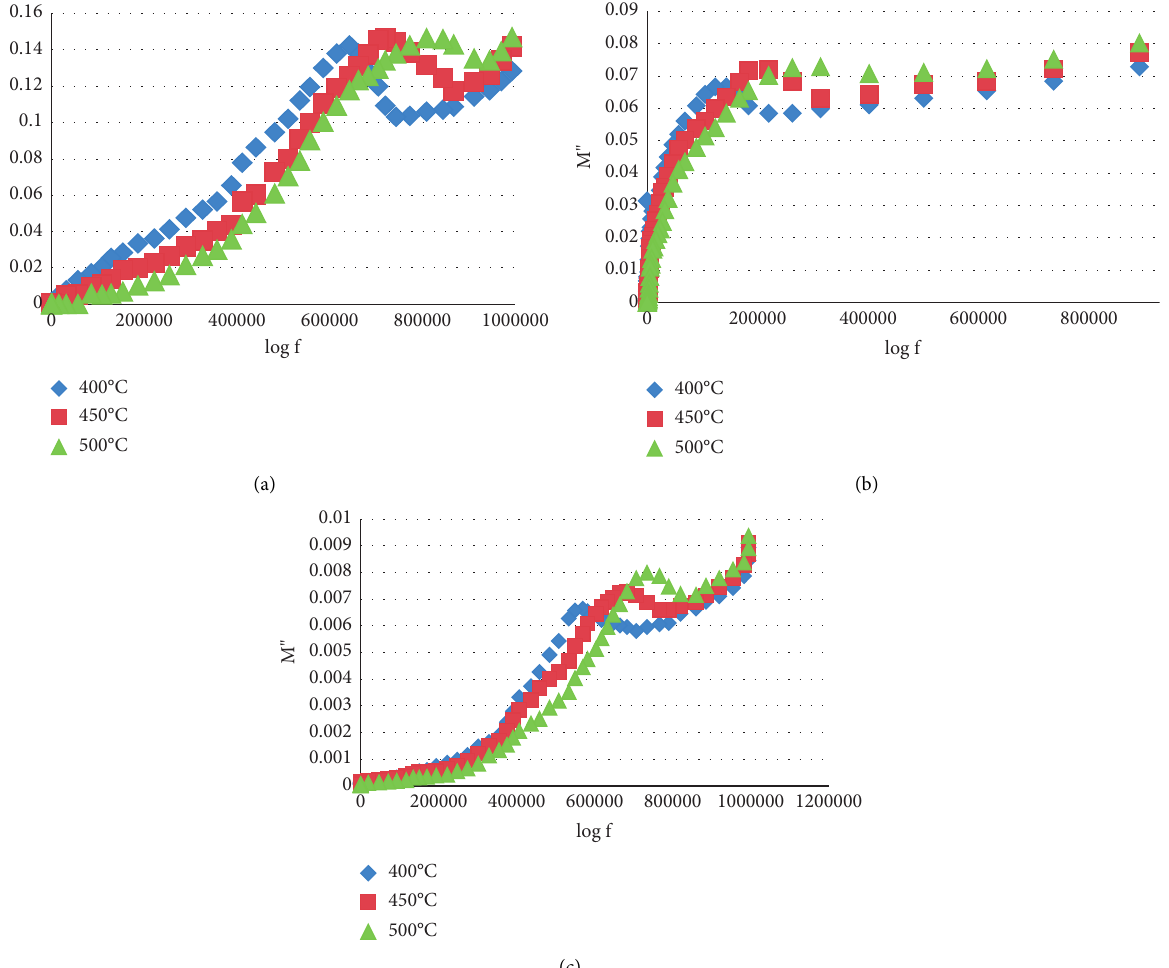
Figure 2: M ″ versus frequency for (a) 0.85PMN-0.15KBT, (b) 0.75PMN-0.25KBT, and (c) 0.65PMN-0.35KBT compositions at different